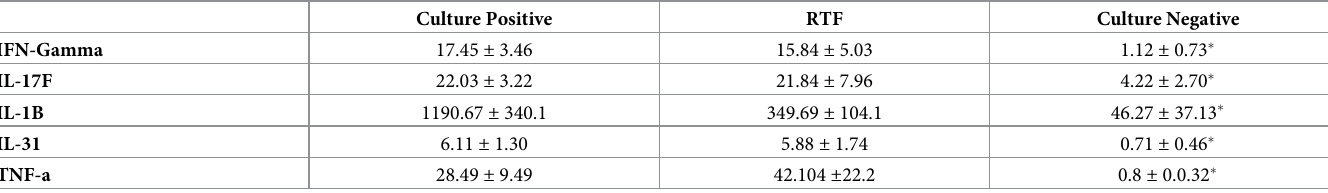
Table 3. Cytokine levels in bronchoalveolar lavage (BAL) of mechanically ventilated trauma